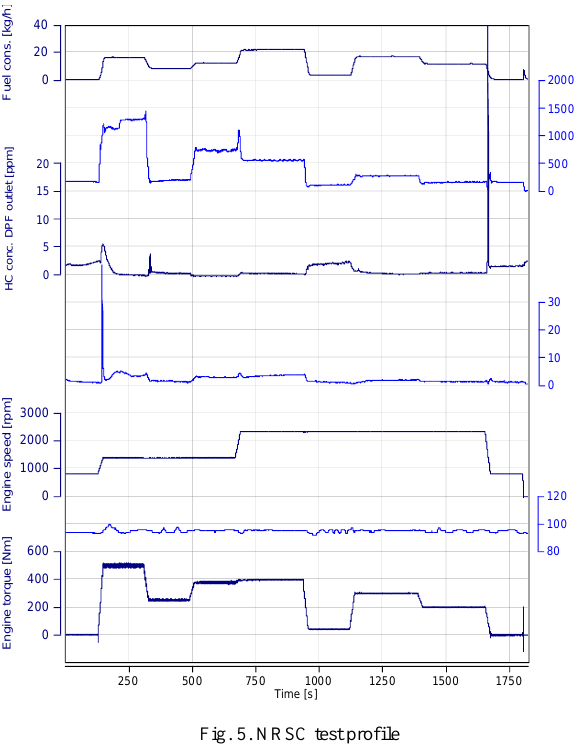
Fig. 5. NRSC test profile